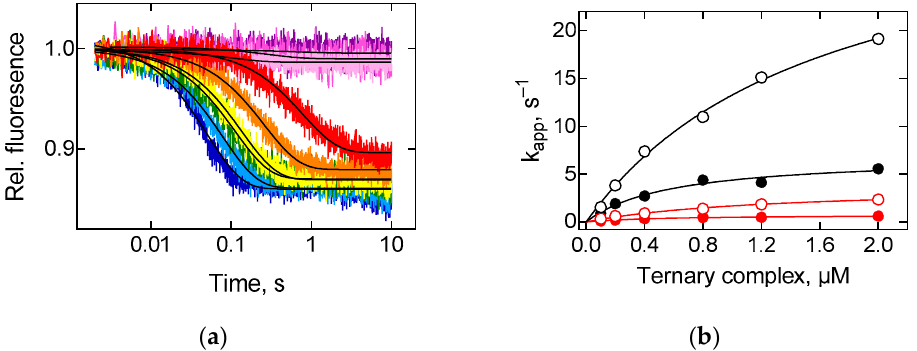
Figure 1. A-site binding kinetics. The ribosomal complexes containing Prf-labelled fMet-tRNA Met in the P site were rapidly mixed with an increasing amount of ternary complex, EF-Tu ∙ GTP ∙ Phe- tRNA Phe . ( a ) Fluorescence time courses of Prf-labelled ribosomal complex (0.05 µM) interaction with ternary complex (0.1 µM, red; 0.2 µM, orange; 0.4 µM, yellow; 0.8 µM, green; 1.2 µM, blue; 2 µM, dark blue), containing EF-Tu from E. coli at 37 ° С . The reaction in the presence of inhibitors of A-site binding kirromycin (150 µM, light pink), tetracycline (30 µM, pink) or with buffer TAKM 7 (violet). Each time course reflects the average of 5–7 technical replicates. Black lines show single-exponential fits. ( b ) Concentration dependence of apparent rate constants (k app ) on ternary complex (0.1–2 µM). k app values were estimated by the single-exponential fitting of time courses as ( a ) for A-site reactions with EF-Tu from E. coli at 20 ° С (black circles), at 37 ° С (black open circles), EF-Tu from T. thermoph- ilus at 20 ° С (red circles), at 37 ° С (red open circles). Lines show hyperbolic fits, and numerical values are provided in the text. Error bars (s.e.m.) are calculated by the GraphPad Prism software from 5 to 7 technical replicates for each concentration; however, they do not exceed the size of symbols.